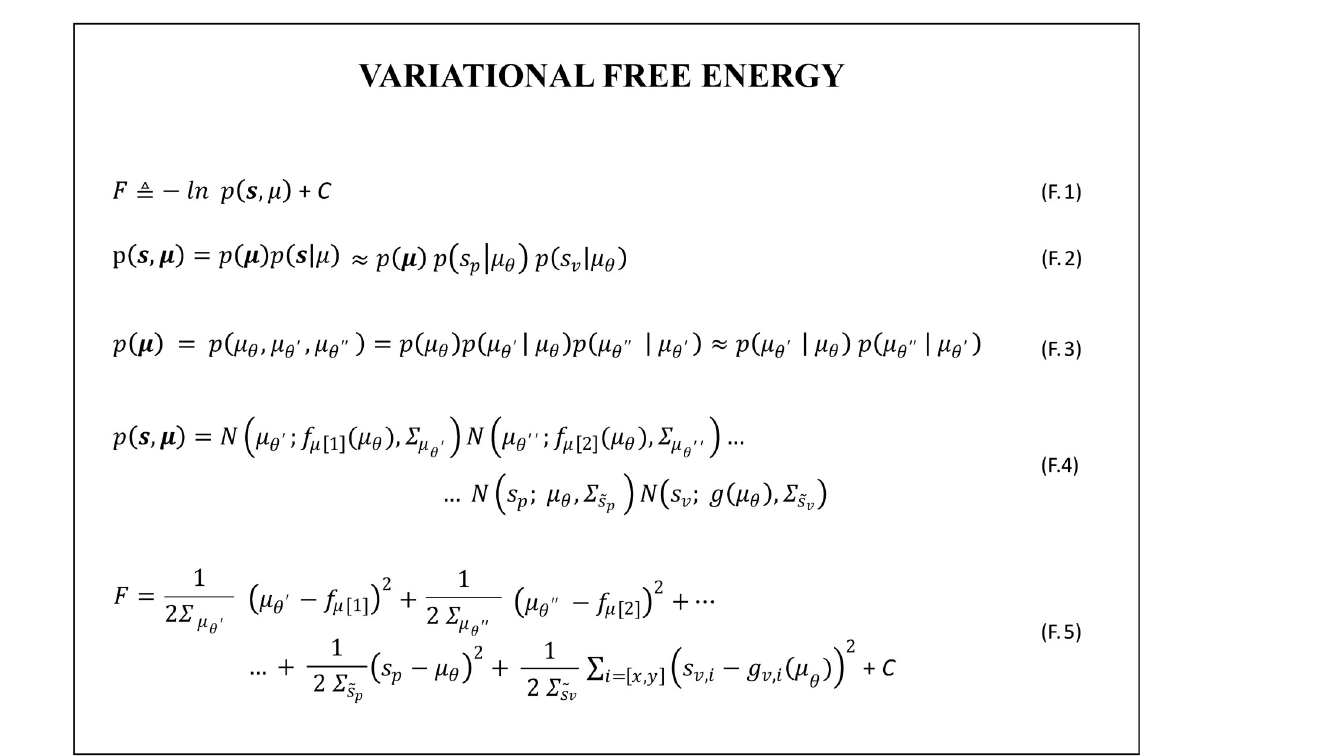
Fig 5. Derivation, under the Laplace approximation, of the variational free energy (VFE), F , for the active inference agent. See S1 Appendix for the detailed derivation of Eq F.1, in which F is expressed in terms of the Laplace encoded energy, and C is a term assumed here to be a constant that encodes the optimal variance (omitted for clarity as it will not be used for computing the gradients as it does not depend on the internal state μ nor the action A ). p( s proprioception and visual likelihood given the internal belief μ θ . p ð m terms of conditional probabilities on the system state as expected from the internal dynamical model. Both the sensory state likelihood and the conditional probabilities are approximated as Gaussians centred on the expected sensory state and the expected value of the dynamics at the different orders (from Eq M.3 in Fig 3) respectively. Please see the main text for a more detailed explanation.